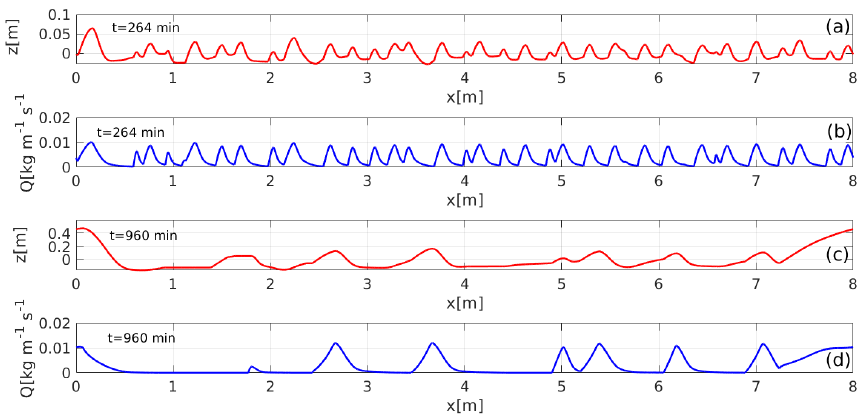
Figure 5. The sand flux over the ripples at t = 264 min (panels ( a , b )) and at t = 960 min (panels ( c , d )). The shadowing effect of the large ripples is clear in the segments with zero flux.